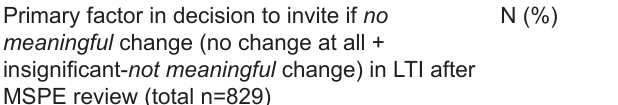
Table 5. Primary factor in decision to invite if there was no meaningful change in LTI after MSPE review and primary factor obtained from MSPE if meaningful LTI changed after MSPE review.